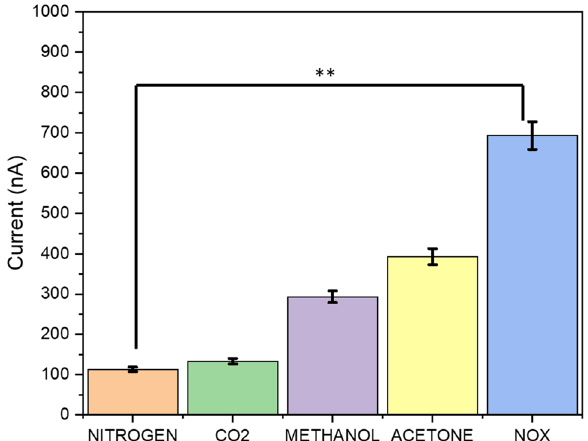
Figure 4. Selective sensing response of the modified electrode–electrolyte interface toward the detection of other gases and volatile chemical compounds, including nitrogen, carbon dioxide, methanol and acetone as compared to selective sensing for NO target